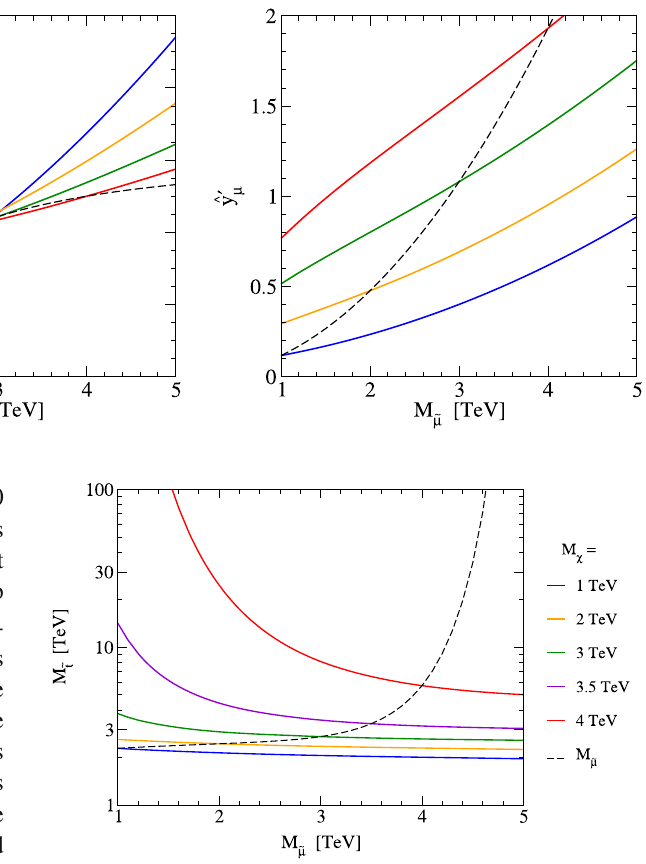
Fig. 2 Values of the stop mass M ˜ t that result in the correct predic- tion for the Higgs mass when tan β d is fixed by the requirement that the smuon-higgsino-gaugino contribution solve the ( g − 2 ) μ anomaly, as a function of the smuon mass M ˜ μ and for different values of the common higgsino/gaugino mass M χ . The remaining free parameters of our simplified FSSM scenario are fixed as tan ˜ β = 20, tan β u = 100, √ X t = 6 M ˜ t and M H = M 3 = M